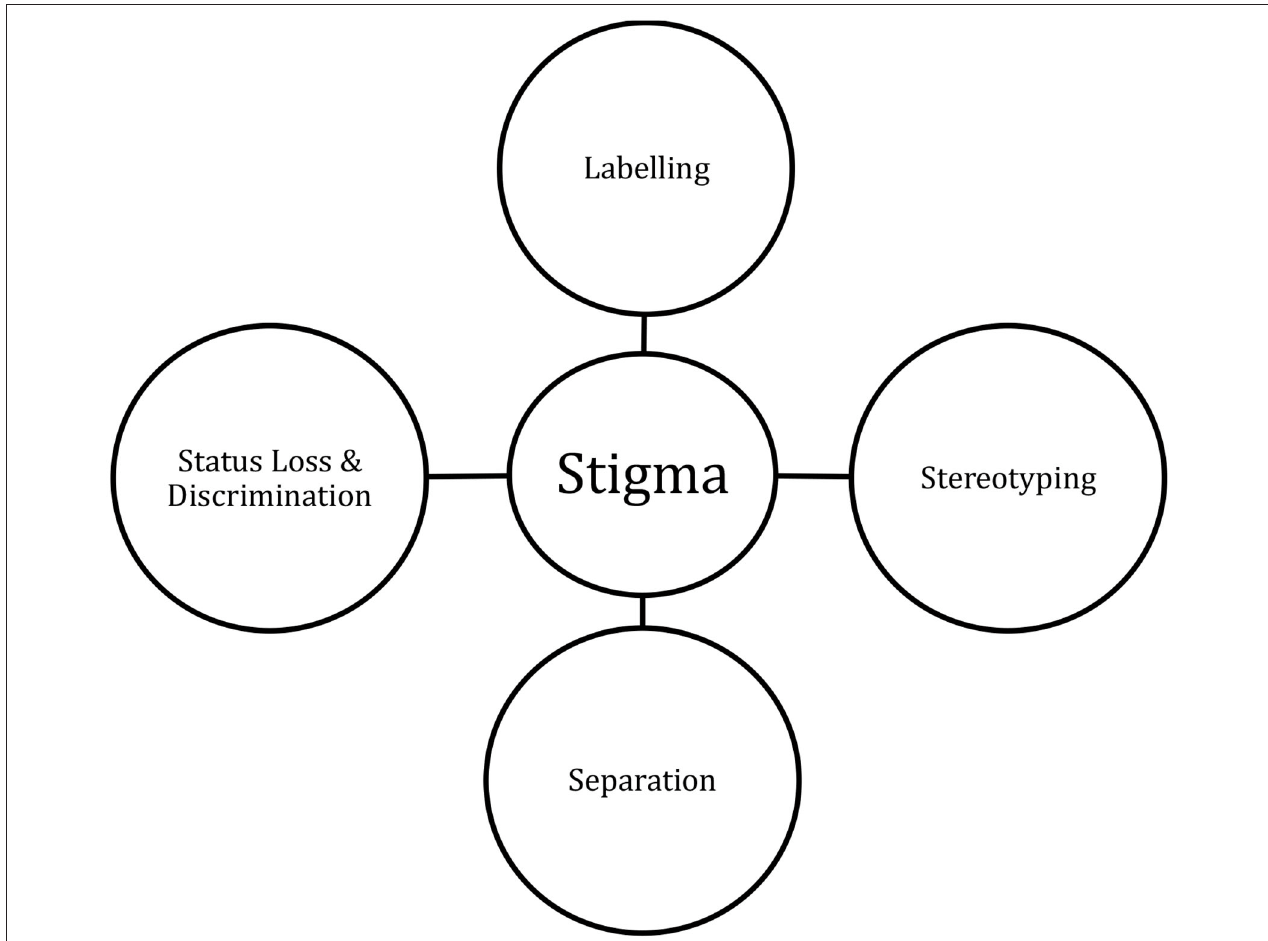
FIGURE 1 | Conceptual framework for identification of stigma. Adapted from Link and Phelan